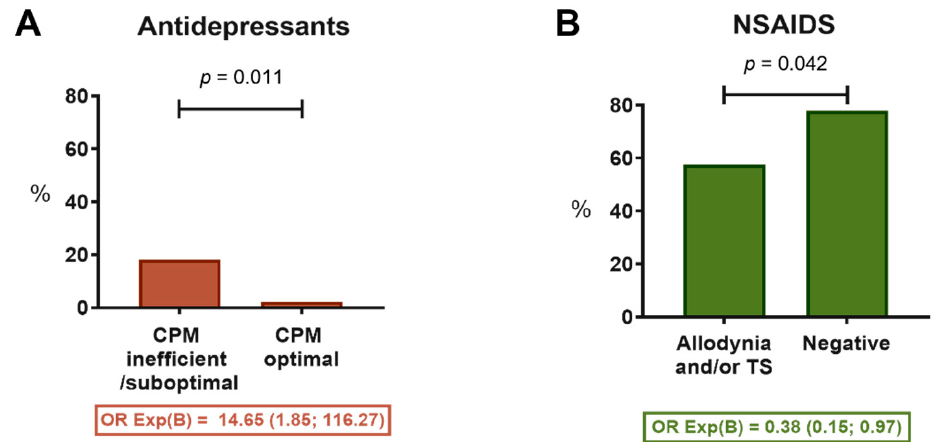
Figure 3. Comparison of medical treatment prescribed at the initial visit specific to QST/CPM recommendations. ( A ) The proportion of patients with a prescription for antidepressants was greater among those with an inefficient or suboptimal endogenous inhibitory pain response; ( B ) The proportion of patients with a prescription of NSAIDs was smaller among those who showed positive signs of allodynia and/or temporal summation (TS). Odds ratios (OR) are